Question: Condense the content of this figure into a single sentence.
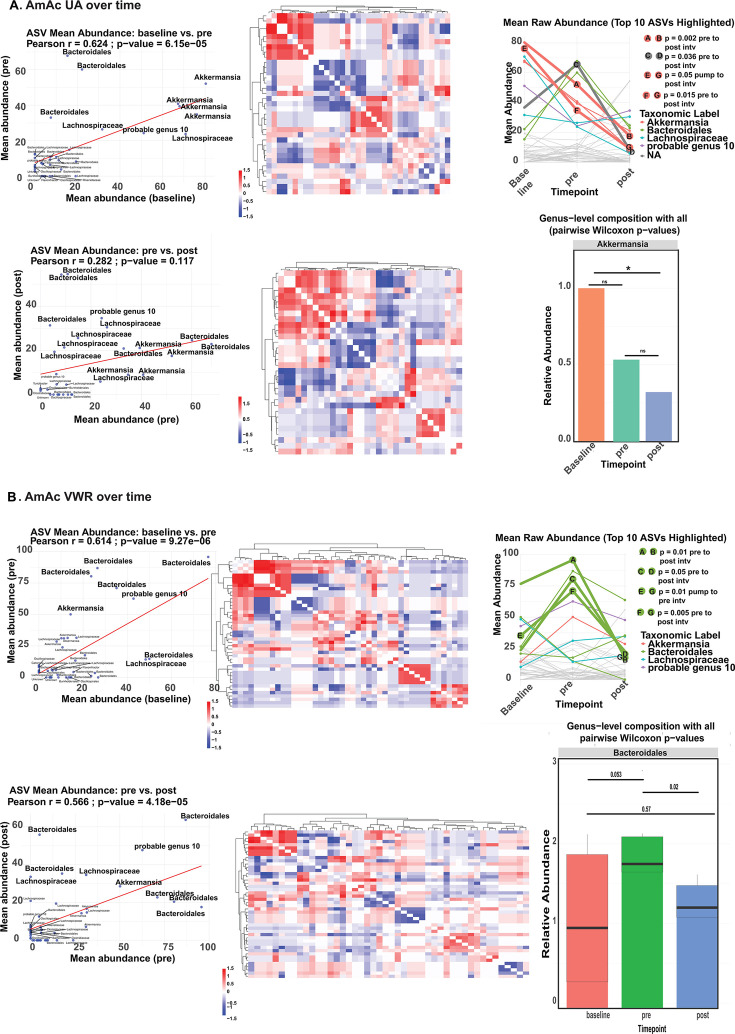
Answer: Temporal dynamics of the altered gut microbiome during exercise under hyperammonemic stress. Male C57BL/6J mice aged 8–10 weeks were treated with either PBS or 2.5 mmol/kg/day AmAc for 42 days (treatment period). Two weeks after the osmotic pumps were installed, mice were randomized to UA or VWR for 4 weeks (intervention period). Stool samples were collected at three time points: baseline (prior to treatment or intervention), pre-intervention (2 weeks post-treatment), and post-intervention (4 weeks post-intervention). The samples were then analyzed at the ASV level. ( A ) AmAc-UA group: scatter plots of ASV mean abundance (baseline vs pre, pre vs post), ASV-ASV network plots at each time point, time-course line plots tracking the top 10 most abundant ASVs, and genus-level abundance comparisons across time points for the most abundant genera. ( B ) AmAc-VWR group: scatter plots of ASV mean abundance (baseline vs pre, pre vs post), ASV-ASV network plots at each time point, time-course line plots tracking the top 10 most abundant ASVs, and time-course tracking of the top 10 ASVs and genus-level comparisons of dominant taxa over time. Data: mean ± SD. Statistical analyses: Pearson correlation was used to assess similarity in mean ASV abundance across time points (pre-intervention vs baseline and post-intervention vs pre-intervention) and to construct ASV-ASV co-abundance networks. For time-course plots of the top 10 ASVs, White’s non-parametric test with pooled variance and 1,000 bootstraps was used to compare abundance across time points. P -values were adjusted using the Benjamini-Hochberg method. * P <0.05. n = 8 mice per group.